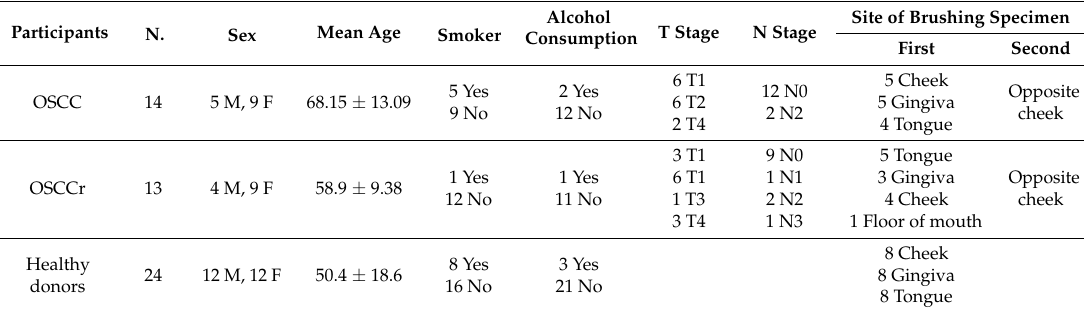
Table 3. Clinical profile of population